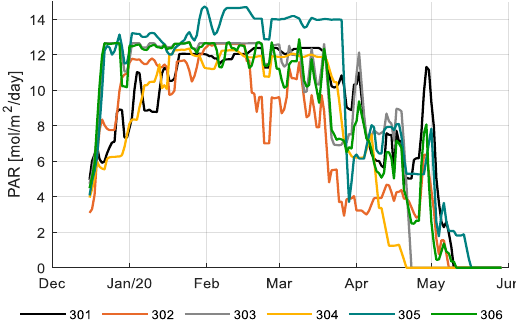
Figure 5. Weekly average total daily photosynthetically active radiation (PAR) light integral (mol/m 2 /d) (natural sunlight and artificial lighting) in the greenhouse compartments (301–306). Figure 6. Daily PAR light integral (mol/m 2 /d) of artificial lighting only in different greenhouse compartments (301–306). Data smoothed by a moving average filter of 3 days.